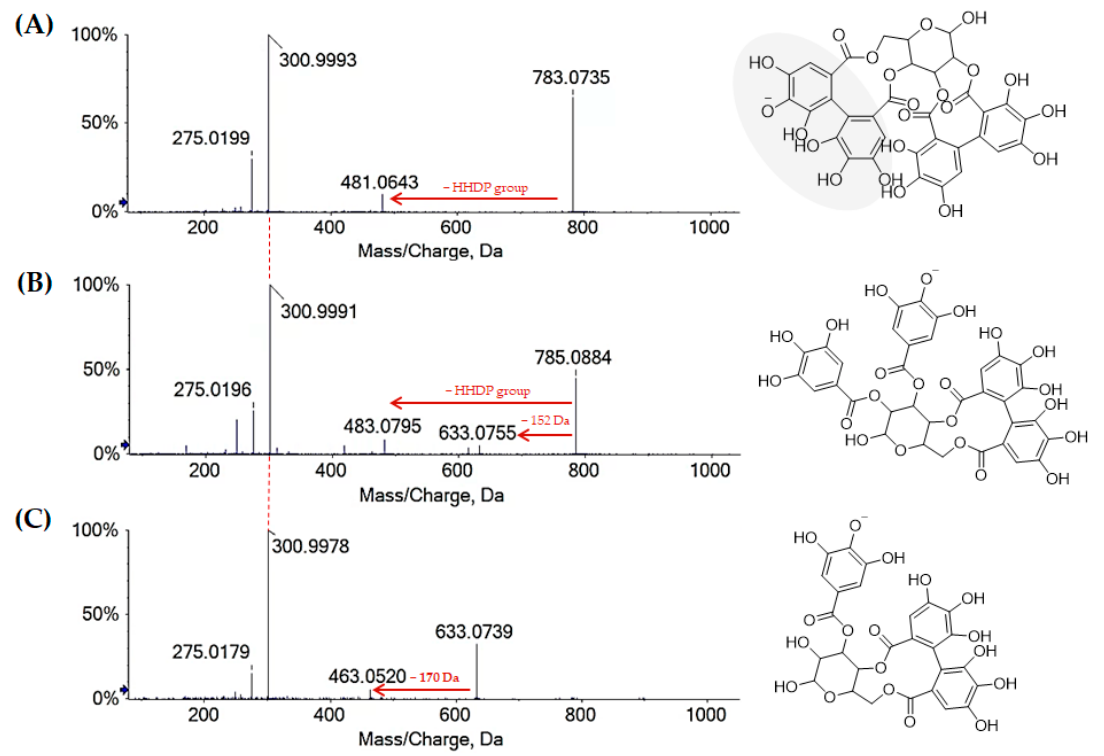
Figure 4. TOF-MS/MS spectra of ellagitannins 13 ( A ), 25 ( B ) and 27 ( C ) with [M-H ] − ions at m/z 783.0735, 785.0884 and 633.0739, which were detected in alcoholic extract Cs/1/1 and its polyphenols enriched extract Cs/3/2.